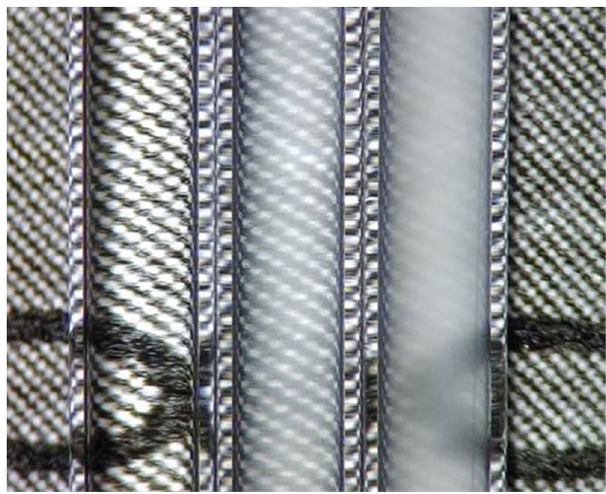
Fig. 3 Hz-catalyzed precipitation polymerization of NIPAAm in glass capillaries. Microscopic photography (×20 magni fi cation)